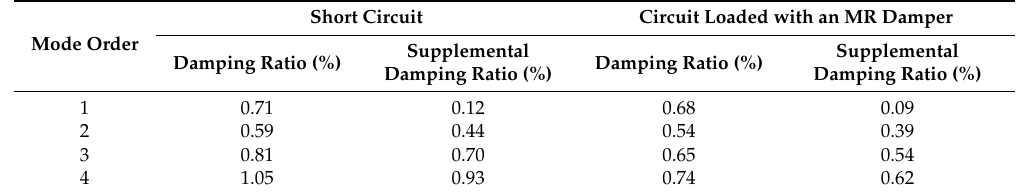
Table 3. Modal damping ratios of the cable in the first four modes with electromagnetic damping alone.